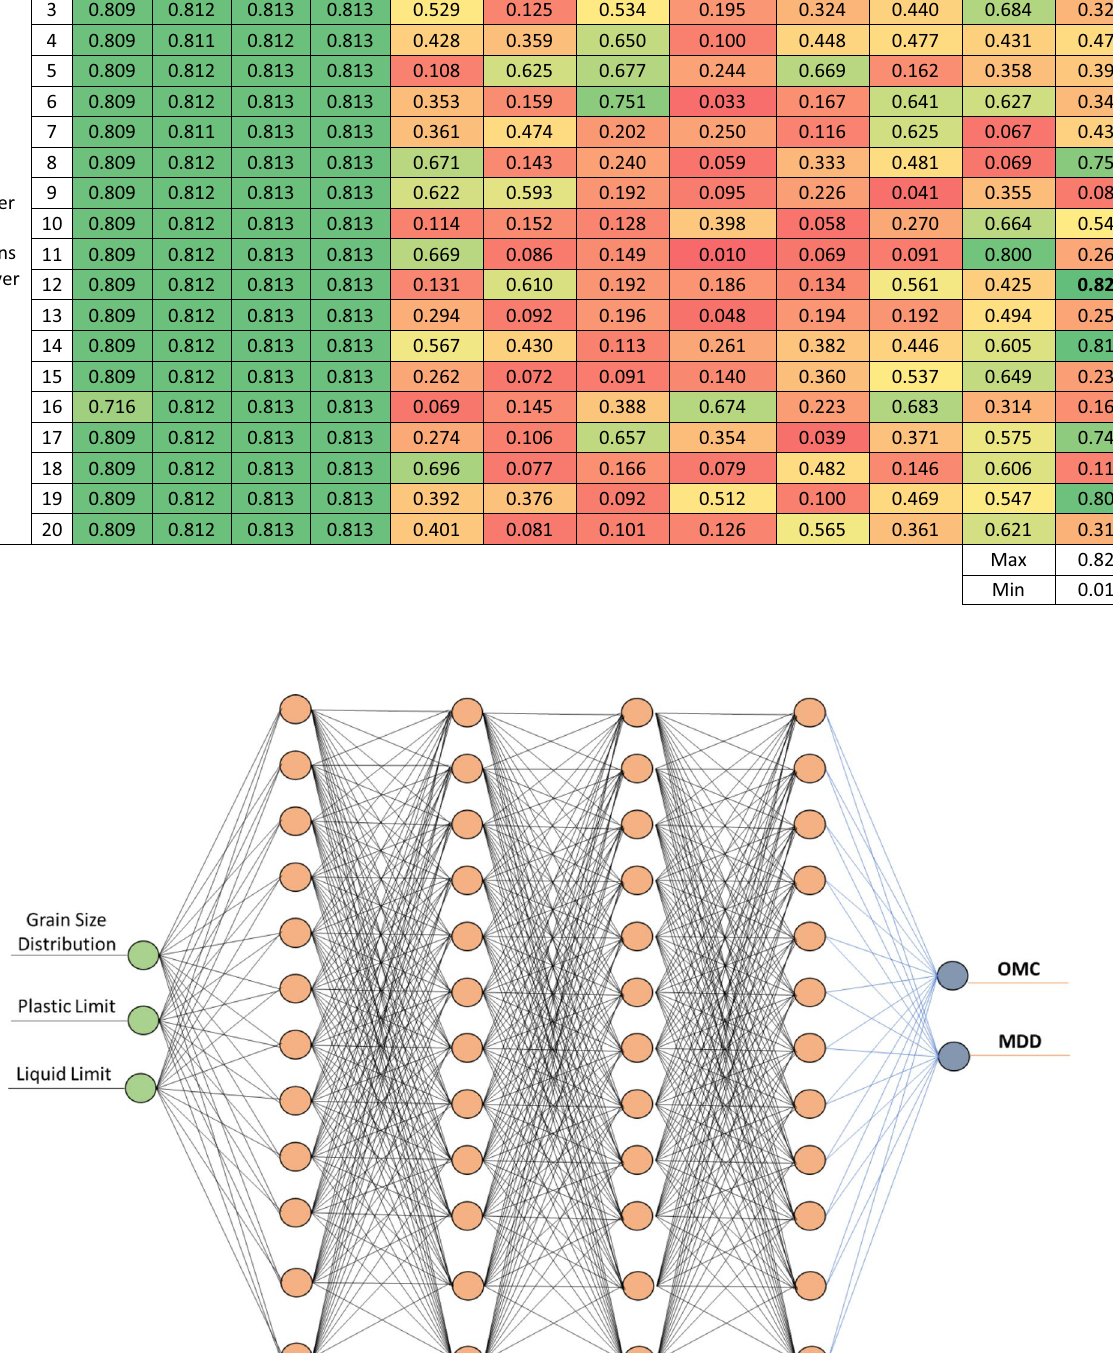
Table 5 Coefficient of determination for the prediction of both the OMC and MDD of the different ANNs tested when used on the testing set Balanced